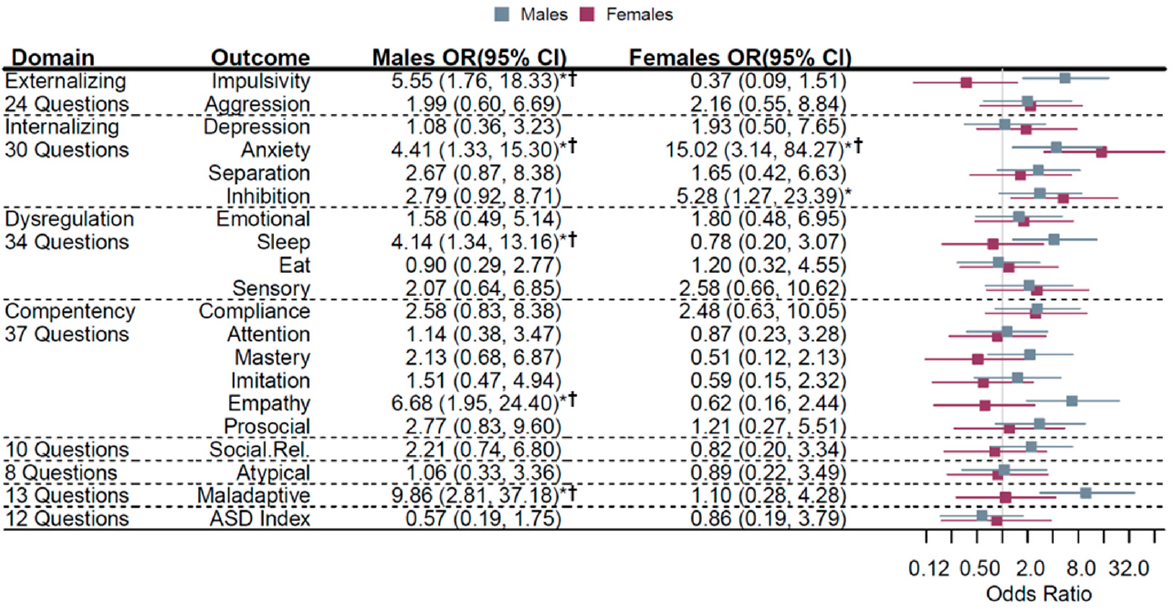
Figure 3. Sex-specific associations of MGL (T3 vs. T1) and offspring temperament. Sex-specific associations with MGL (tertile 3 vs. tertile 1) and offspring behavioral outcomes. For a given tertile of MGL compared to tertile 1 (referent), the odds ratio (95% confidence interval) represents the risk of being in a higher tertile of behavioral outcome. Males (gray) and females (magenta) odds ratios (95% confidence intervals) are plotted. Estimates were adjusted as before stratified by sex. * p < 0.05; † Benjamini–Hochberg FDR < 0.10.